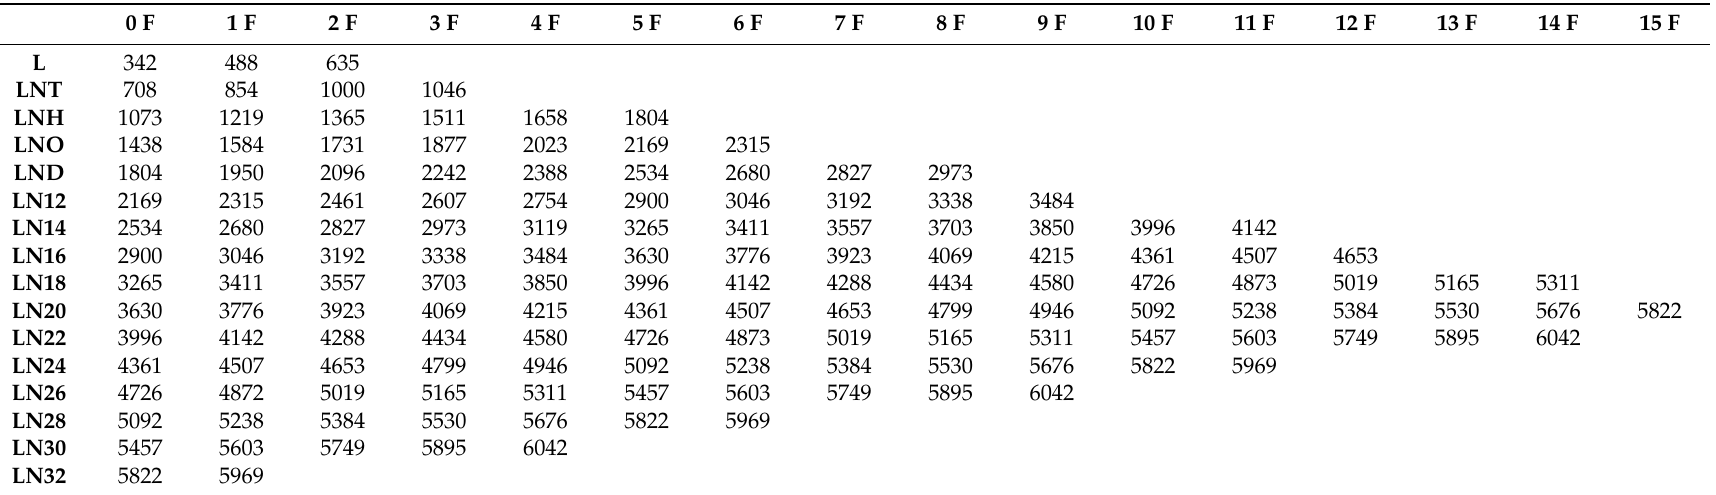
Table 1. Molecular weights of neutral oligosaccharides from human milk found by MALDI-MS. F—fucose. L—lactose, LNT—lacto- N -tetraose, LNH—lacto- N -hexaose, etc. Reproduced with permission from [47]. Copyright American Chemical Society,